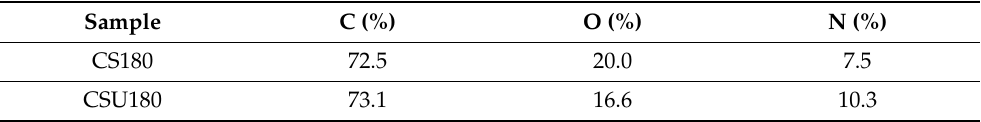
Table 1. Elemental composition of Table 2. Relative intensities of the N 1s bands (surface area of the bands).